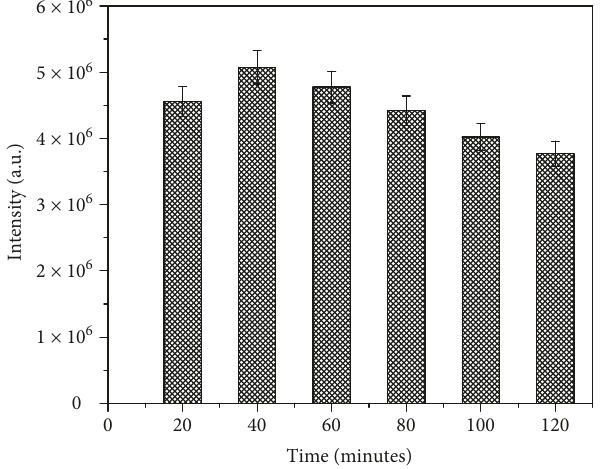
Figure 11: (cid:129) OH trapping experiment over AC-ZnO under UV